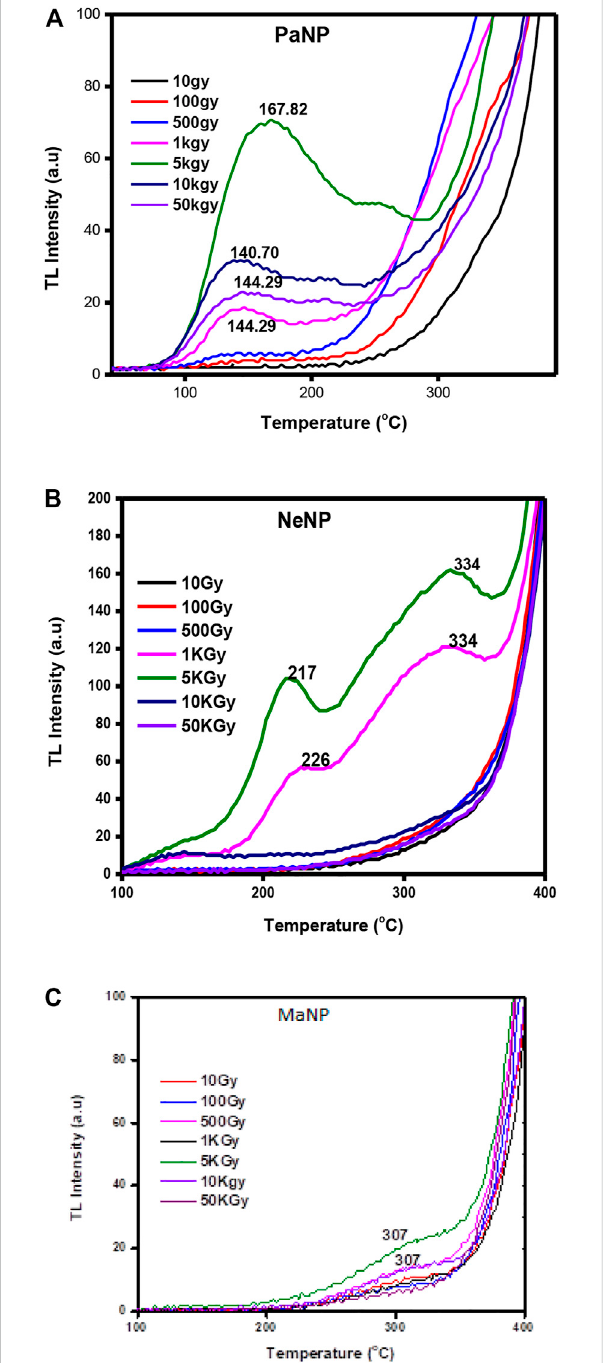
FIGURE 6 Thermoluminescence glow curve of (A) PaNP, (B) NaNP, and (C) MaNP at dose range from 10 to 50 KGy.